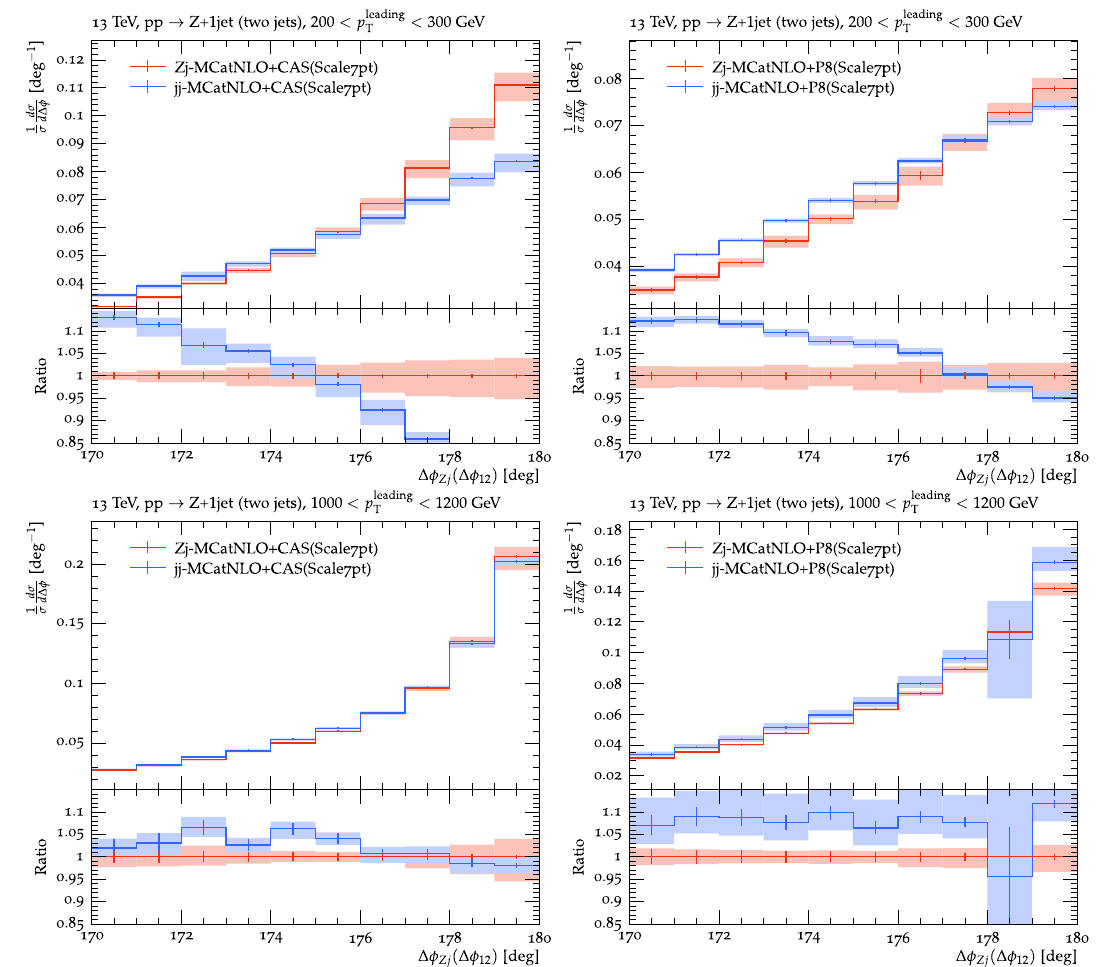
> 200 GeV (upper row) umn). Shown are different regions in p leading T > 1000GeV (lowerrow).Thebandsshowtheuncertainties and p leading T obtained from scale variation (as described in the